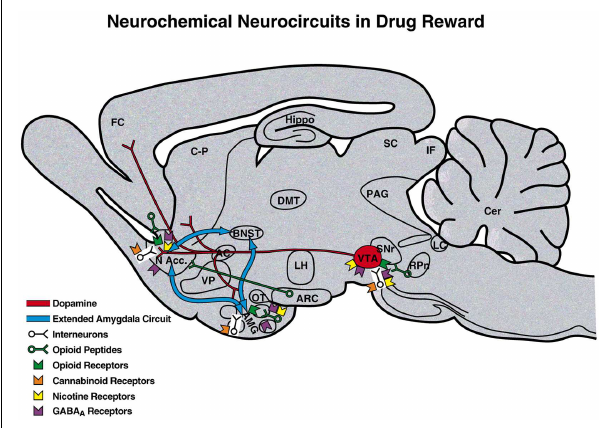
FIGURE 2 | Neurotransmitter pathways and receptor systems implicated in the acute reinforcing effects of drugs of abuse within the medial forebrain bundle . A sagittal rodent brain section is shown.The medial forebrain bundle represents ascending and descending projections between the ventral forebrain (nucleus accumbens, olfactory tubercle, and septal area) and ventral midbrain (ventral tegmental area; not shown in figure for clarity). Cocaine and amphetamines increase dopamine levels in the nucleus accumbens and amygdala via direct actions on